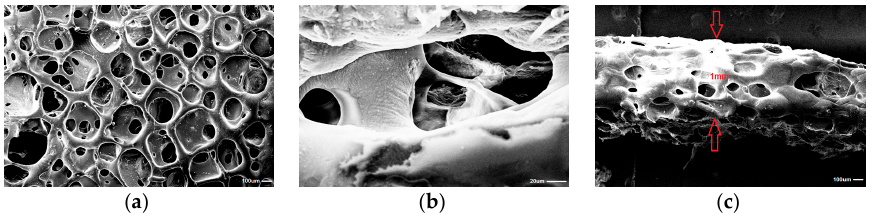
Figure 5. SEM micrographs of MPTL scaffold: ( a ) surface ×100; ( b ) scaffold interior ×10,000; and ( c ) scaffold thickness ×100 times. and ( c ) scaffold thickness × 100